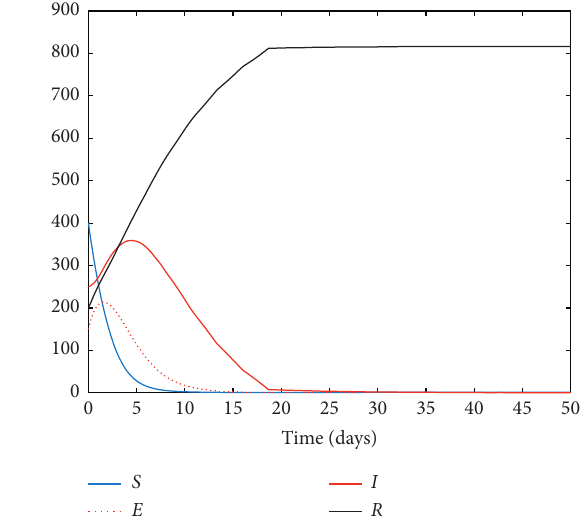
Figure 17: Evolution of the closed-loop system when the adaptive small sampling time procedure is